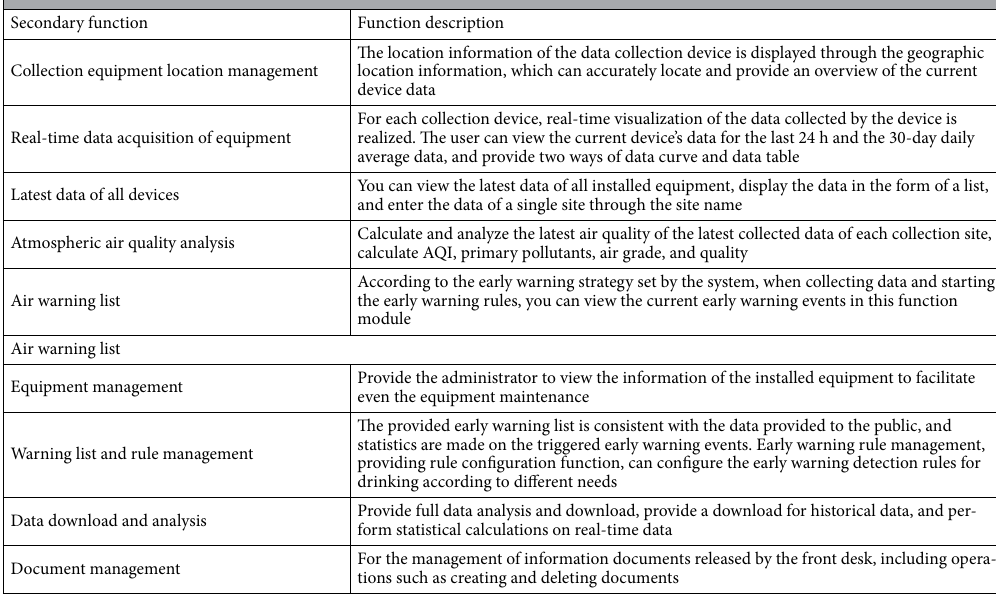
Table 5. The function and function description of the